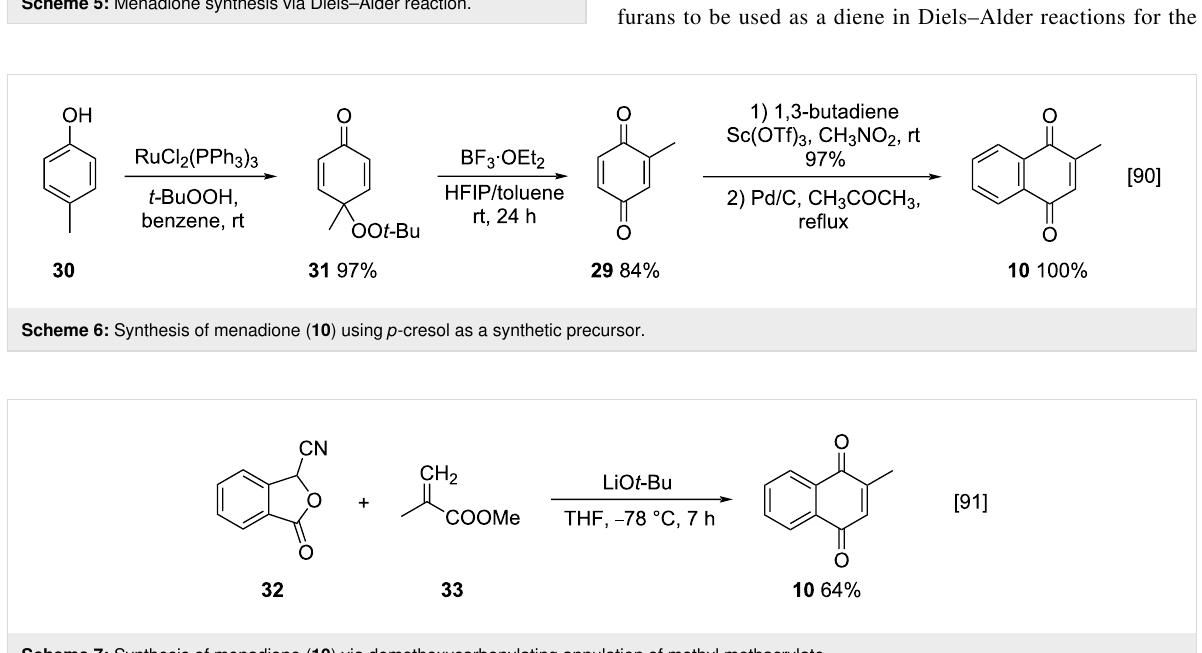
Scheme 7: Synthesis of menadione ( 10 ) via demethoxycarbonylating annulation of methyl methacrylate.